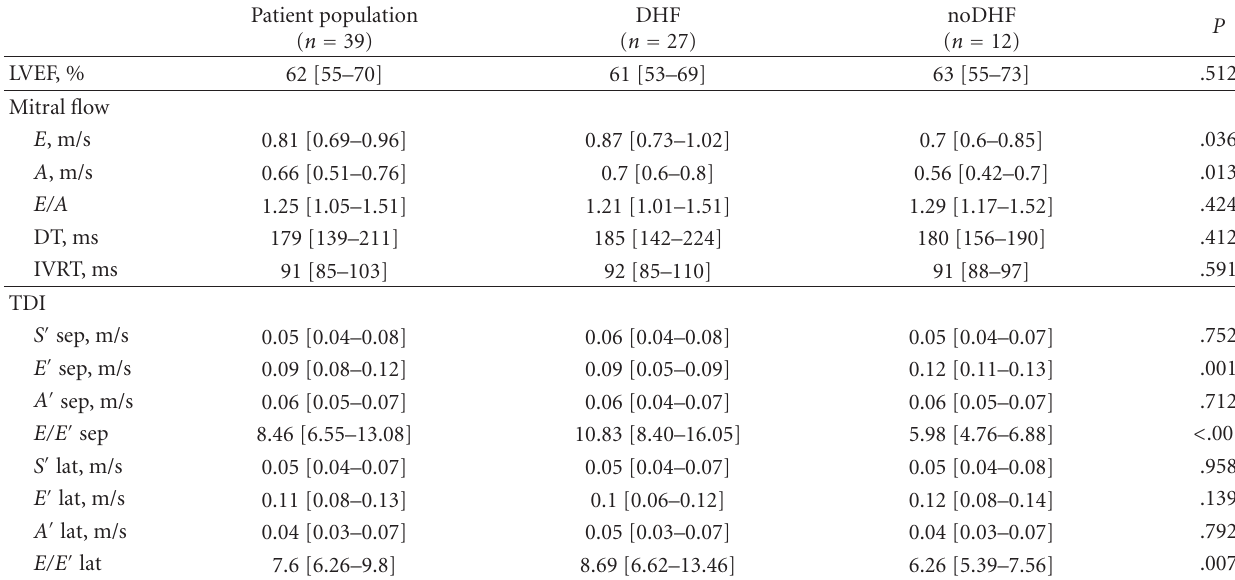
Table 3: Indices of conventional and TDI echocardiography (variable expressed as median [25–75% quartile]). Patient